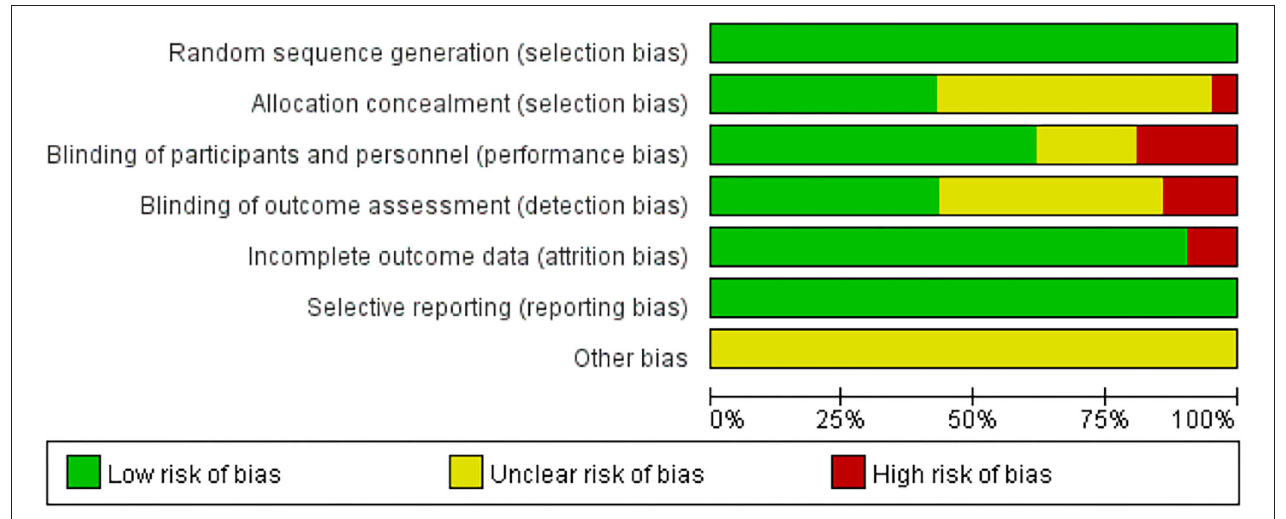
FIGURE 2 | Risk of bias of the included studies.